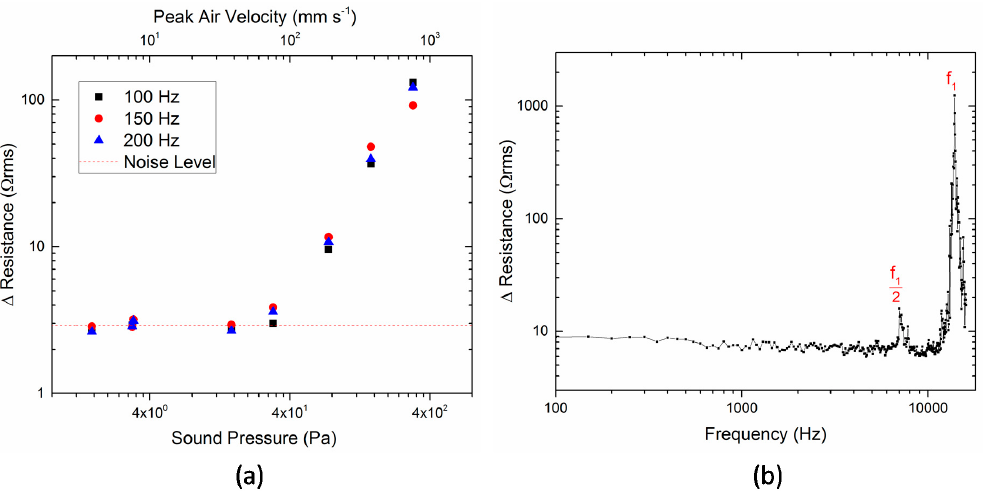
Figure 3. ( a ) The RMS change in resistance of Sensor 3 ( L E = 4.37 mm) as function of sound